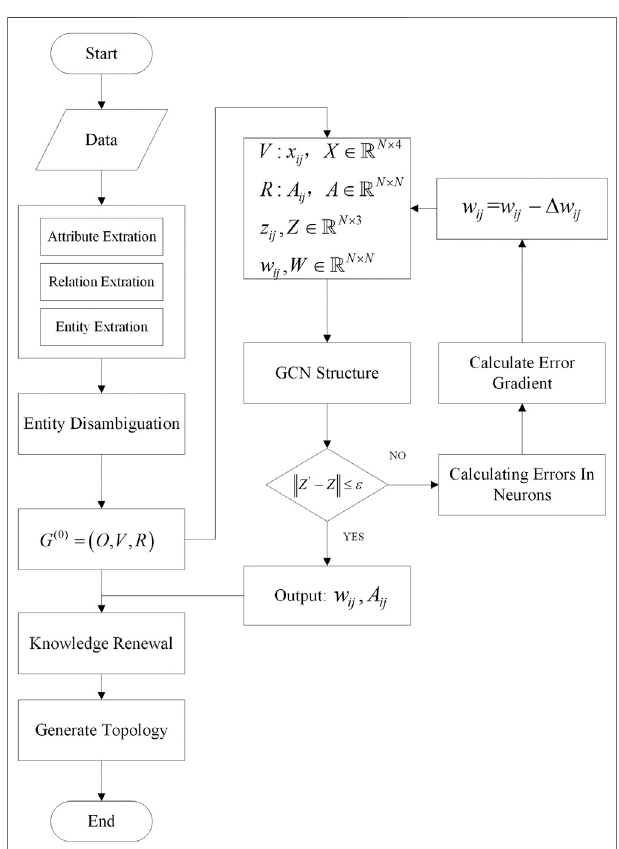
FIGURE 5 | The fl owchart of the proposed method.